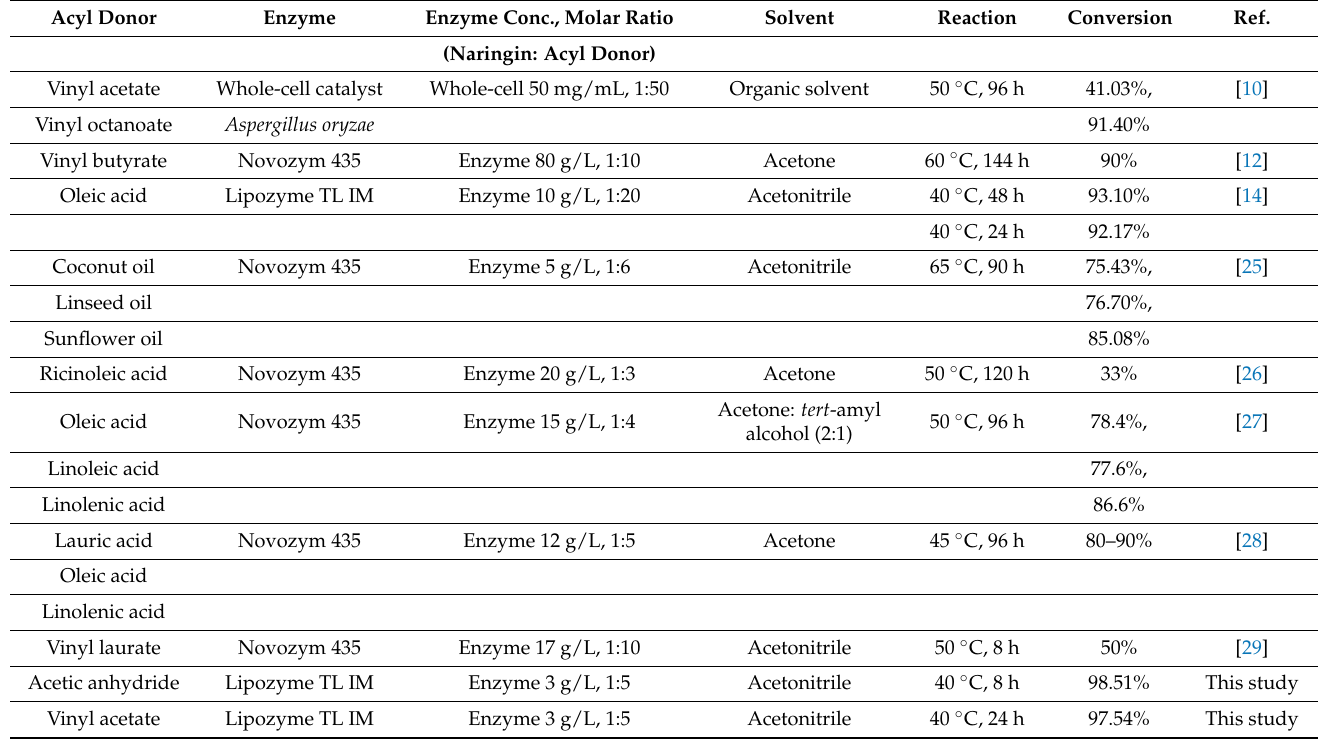
Figure 6. Conversion of naringin acetate as a function of reaction time (3 g/L of Lipozyme TL IM, acetic anhydride or vinyl acetate as the acyl donor, 1:5 molar ratio of naringin to acyl donor, reaction temperature of 40 °C, acetonitrile as the solvent, and reaction time of 48 h). Table 5. Summary of reaction conditions for the synthesis of naringin esters by